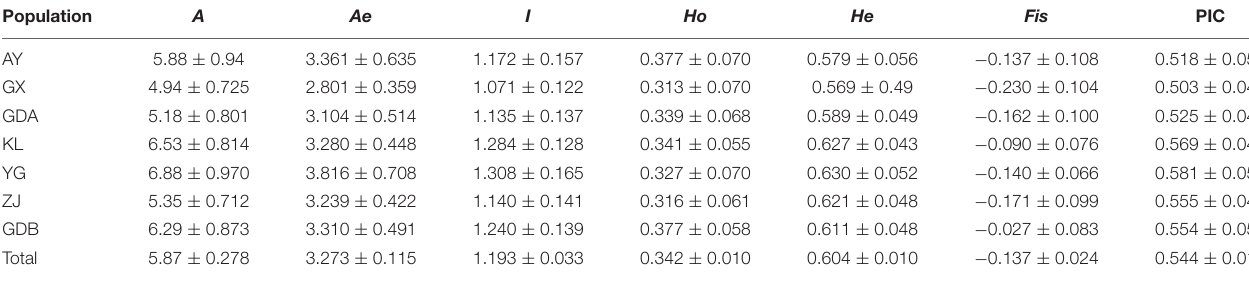
TABLE 4 | Genetic variability at seventeen microsatellite loci in seven populations of M. rosenbergii .